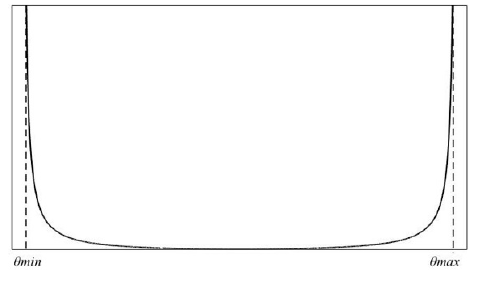
Figure 2. The graph of the objective function.